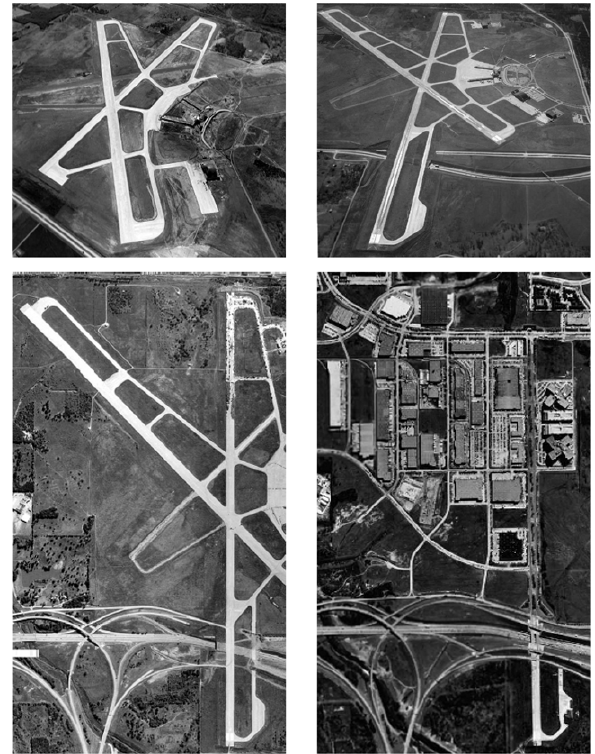
Figure 4. The aerial view show us a sequence of the frenetic transformation of Greater Fort Worth International Airport (note North is at the bottom): 1953 GFW as renovation of Midway airport; 1968 GFW expansion; Ca 1975 GFW disassembly; Ca 1980, the main runway (17/35) was decommissioned to become Amon Carter Boulevard, the backbone of the new Centre Port industrial estate